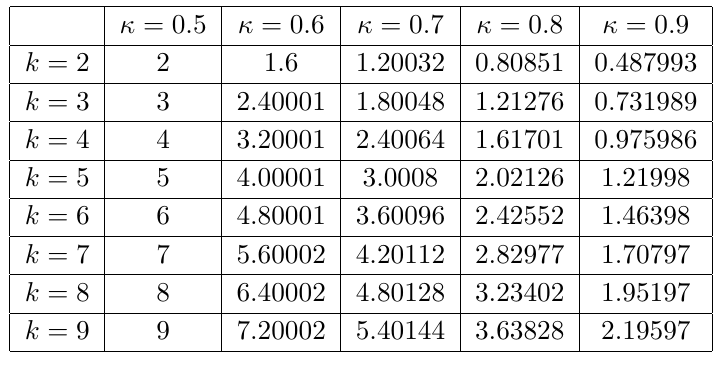
Table 2 . Approximation of [det(1 (cid:0) ^ K )] (cid:0) 1 for some twist parameters and levels. and Y UV a